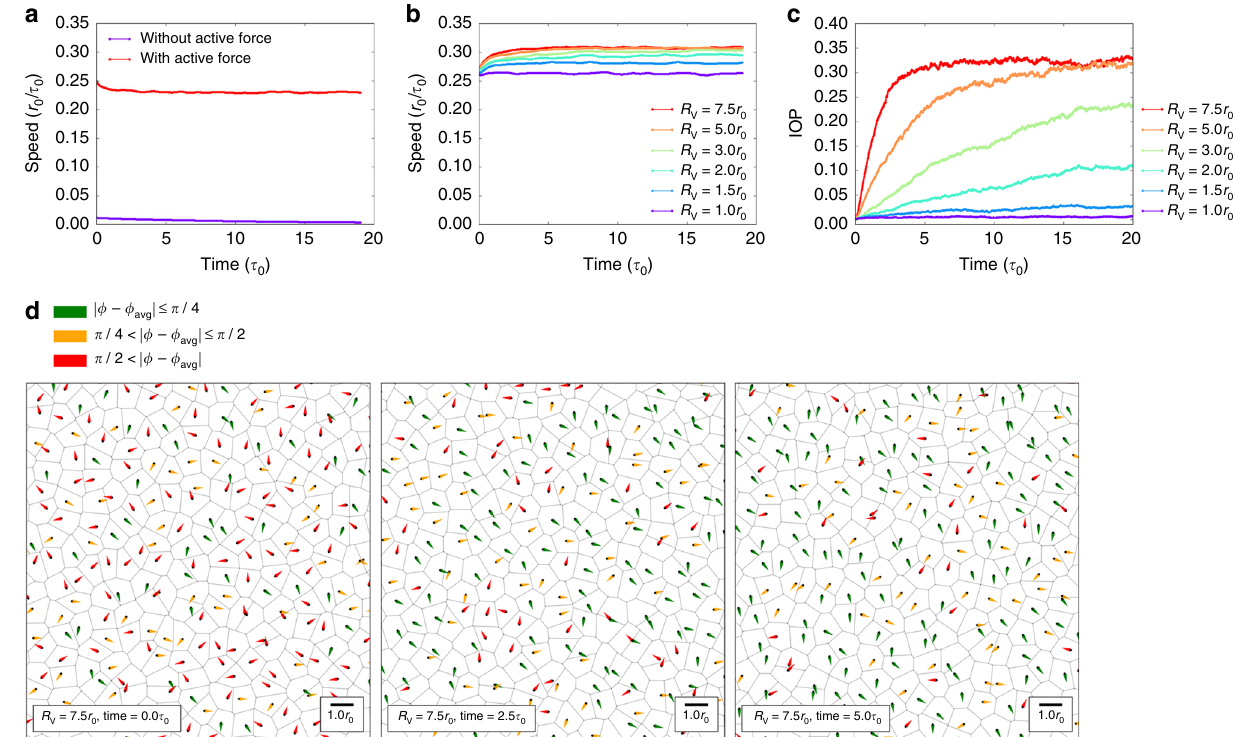
Fig. 3 Numeric simulations of serum-induced collective migration. a Time-dependent average cell speed obtained from simulations in the presence and absence of self-propelling forces. b Time-dependent average speed and c instantaneous order parameter (IOP) obtained from simulations of active cells with varying Vicsek radii, mimicking the effect of varying cell – cell connectivities. d Simulation snapshots at different times t for strongly connected cells with Vicsek radius R 7 : 5 r 0 . The arrows indicate the cells ’ instantaneous velocity directions, and are color-coded by their deviation from the V ¼